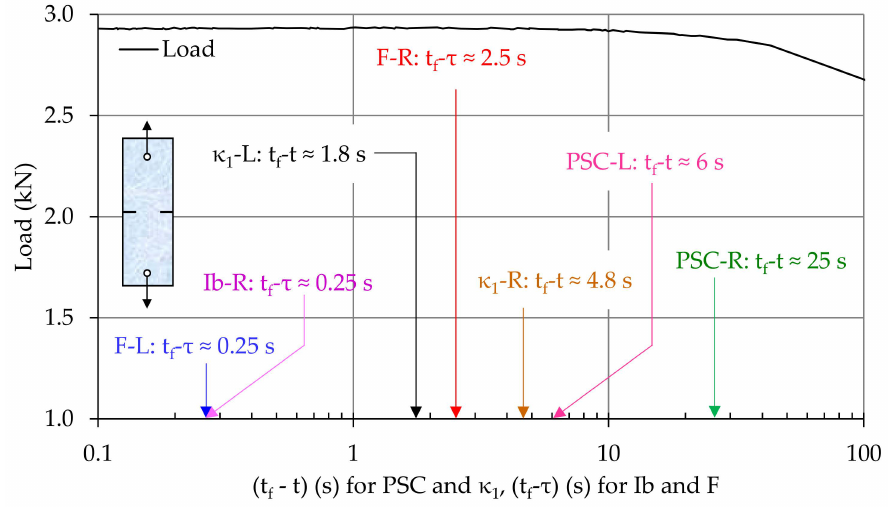
Figure 17. The temporal variation of the applied load, the time instants at which the power law becomes dominant for Ib, F-function and PSC, and the instant at which criticality is indicated by the natural time, for a typical specimen of the protocol with notched marble plates under tension.